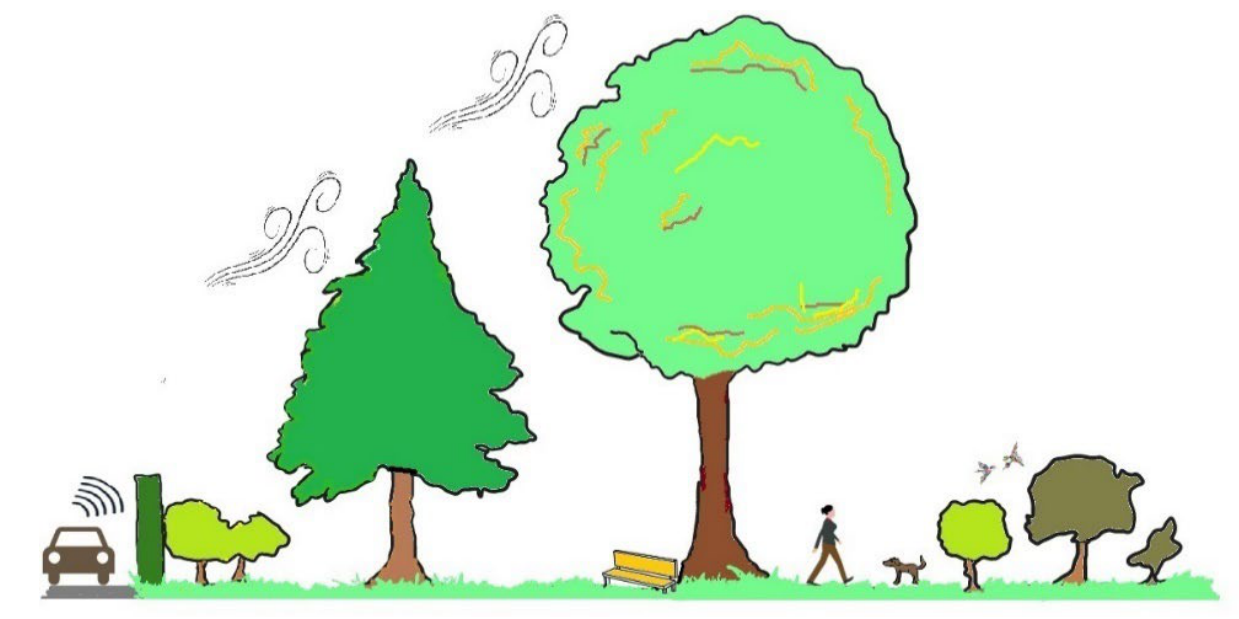
Figure 2. Ornamental plants and their potential positive effects on urban and peri-urban envi- ronments. A combination of species with vegetation from the ground can be used as noise bar- riers, and species with high density foliage can be used as shields for wind protection. Through their transpiration, they can reduce temperature, and with their canopy, they can created shadow areas for relaxing during the summer. Different species increase the biodiversity in urban and peri-urban areas.